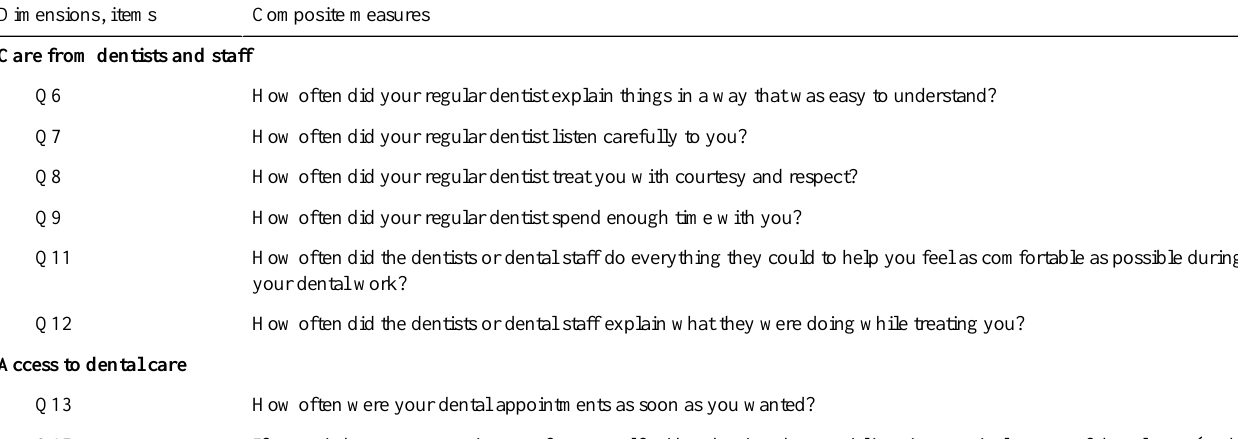
Table 1. Composite measures from the Patient Experience Measures from the CAHPS Dental Plan Survey. Composite measuresDimensions,